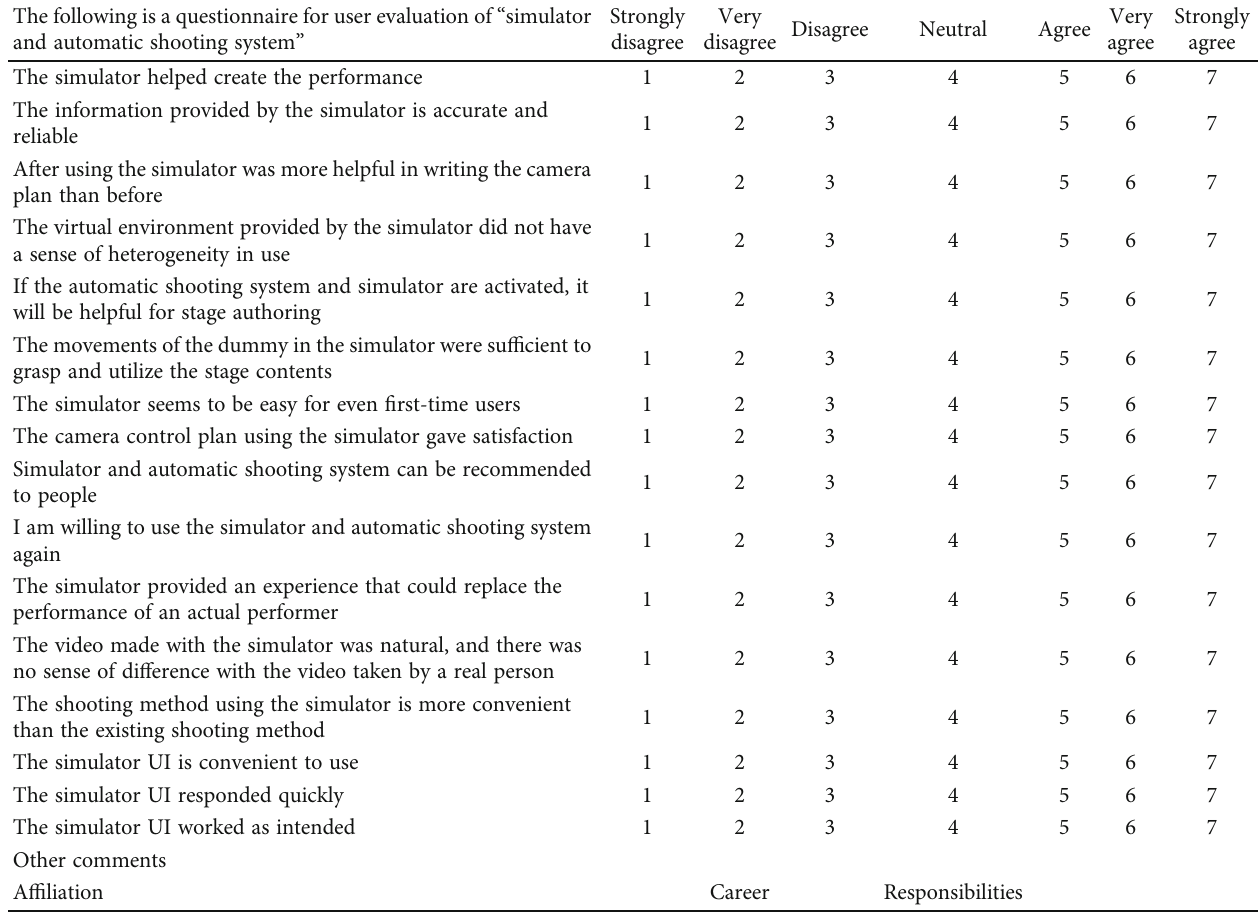
Table 1: Questionnaire for user evaluation of simulators and automatic shooting